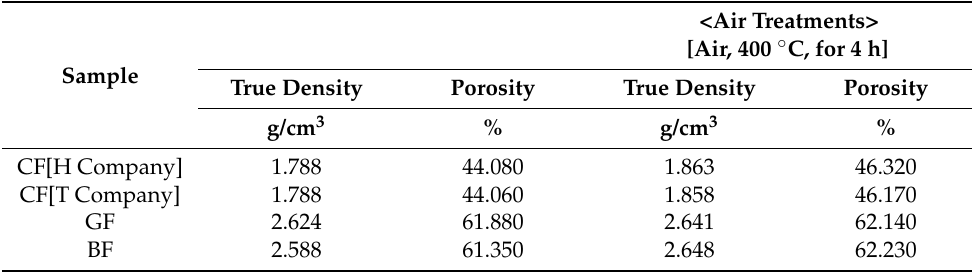
Table 5. True density and porosity of the fibers and oxidized fibers.